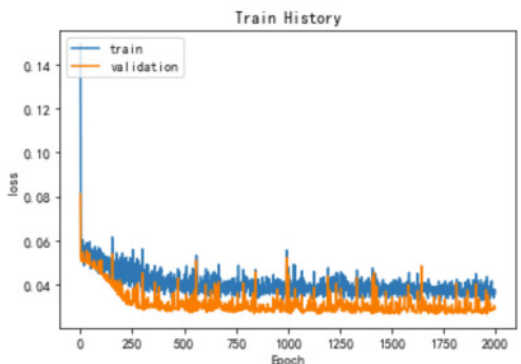
Figure 10. A320 Variation of iteration number error.